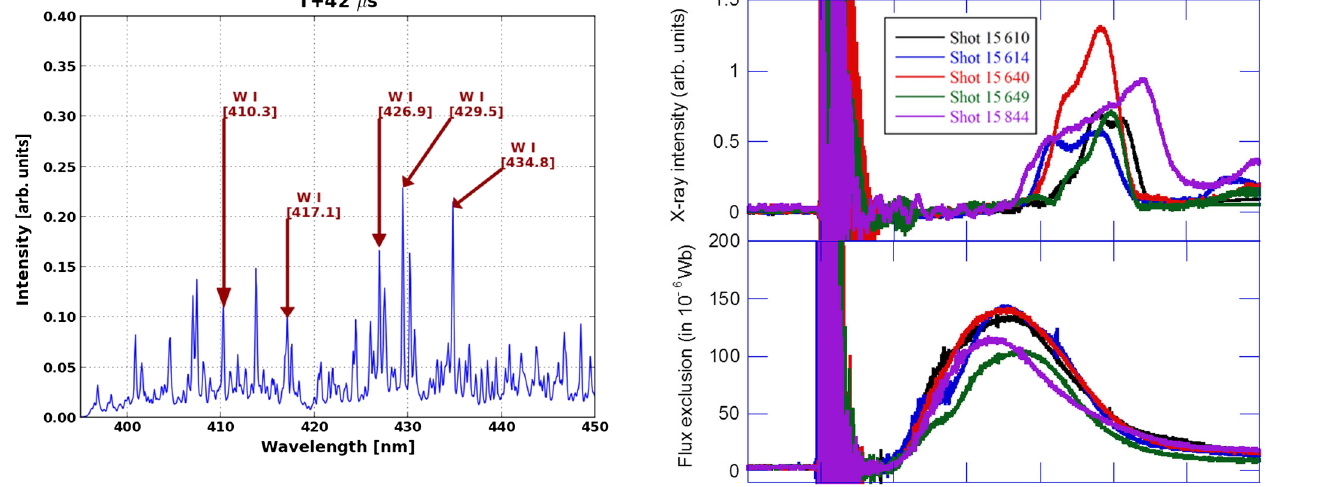
9. Time-integrated spectra of the cusp plasma between 42 and 50 μ s after the plasma injection.